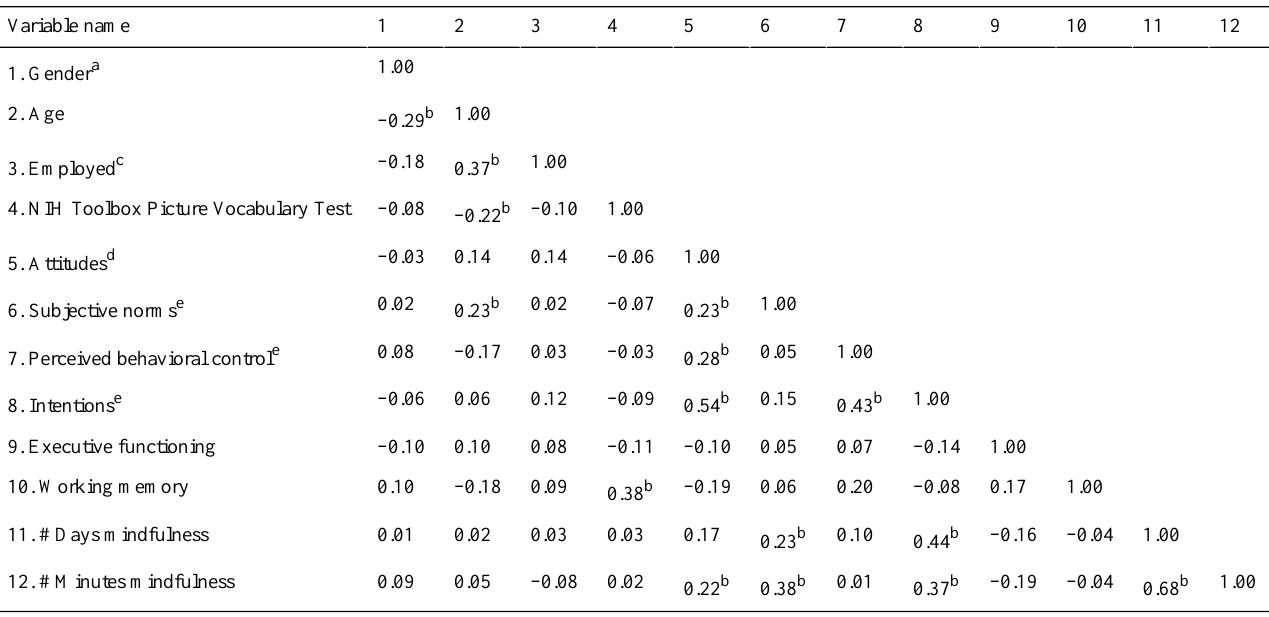
Table 3. Correlations ( r ) of demographic and key study variables